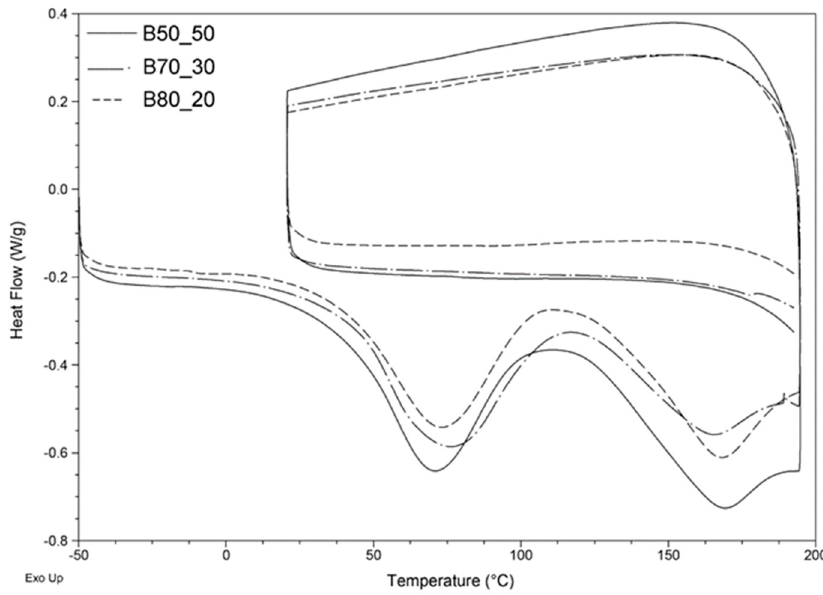
Figure 4. Differential scanning calorimeter (DSC) of B50_50 (solid line), B70_30 (dashed line) and B80_20 (dotted line).